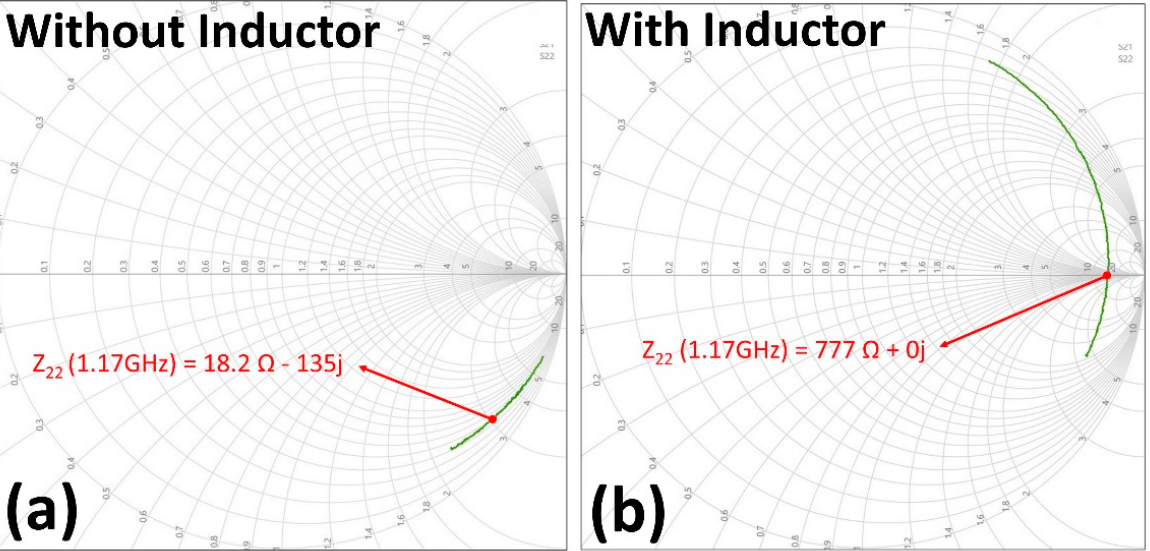
Figure 6. Measured S 22 parameters plotted on a Smith chart without ( a ) and with ( b ) the SMD inductor. Z 22 values are displayed for 1.17 GHz.